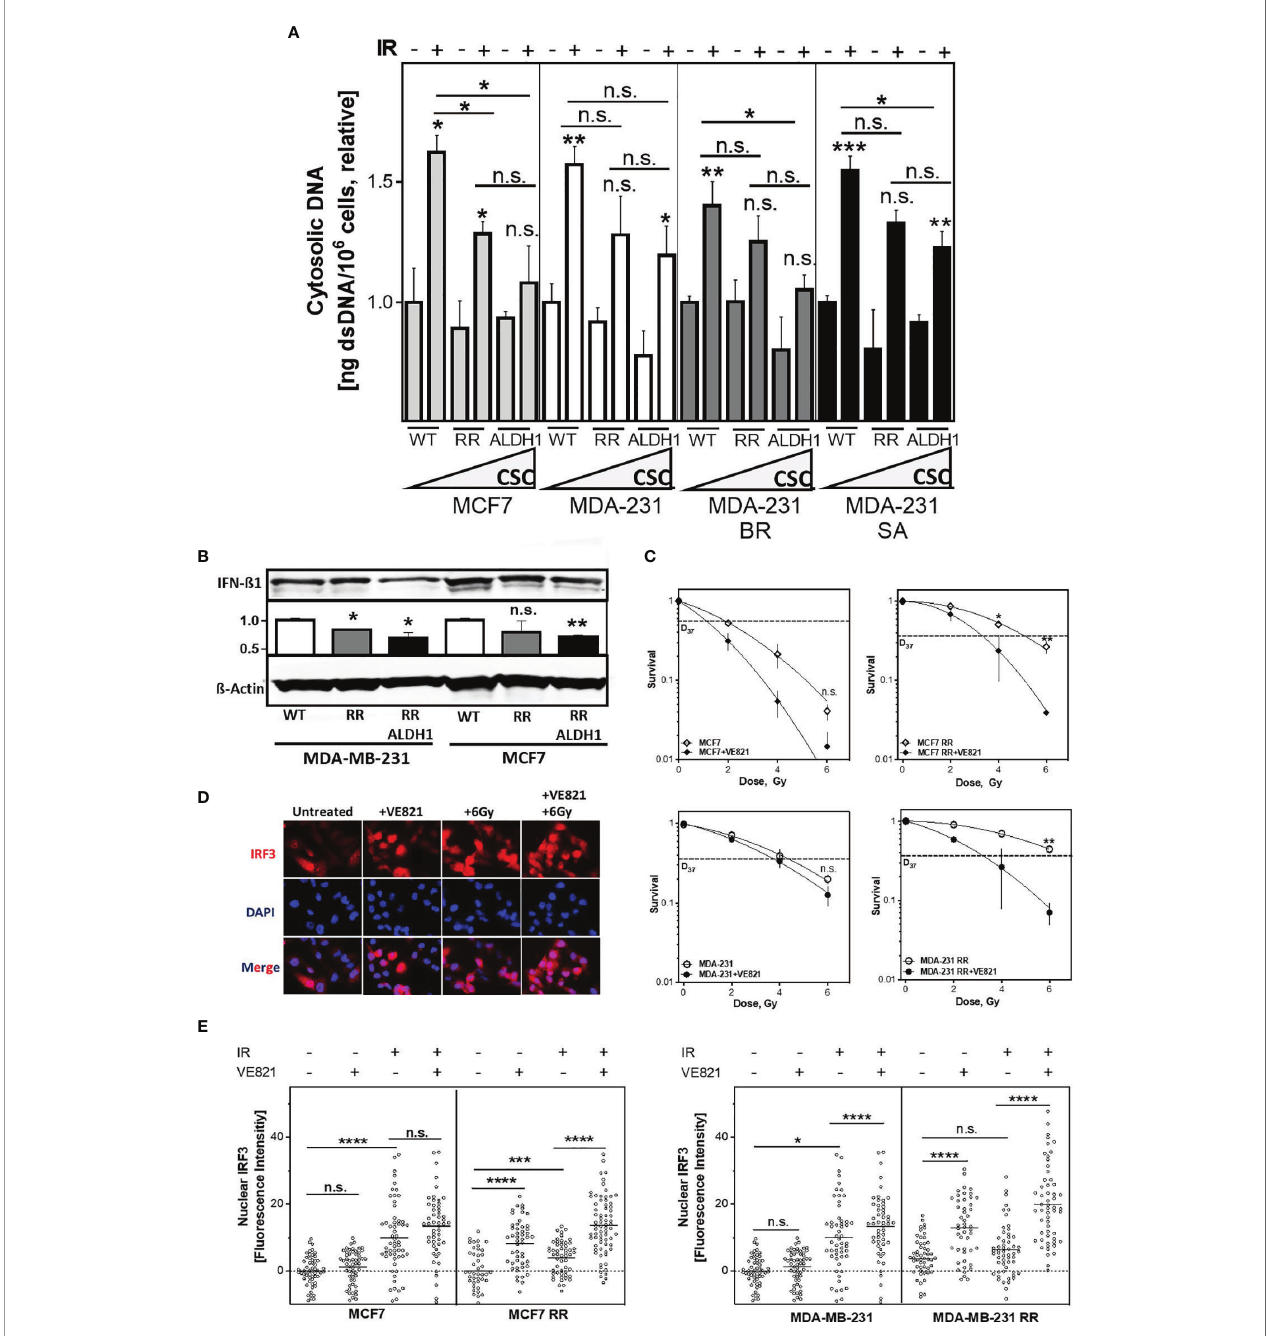
FIGURE 5 | The amount of cytosolic DNA and intracellular immune response depends on the ALDH1-positive BCSC proportion. (A) Relative increase of cytosolic dsDNA after irradiation. Cells were irradiated with 8 Gy, cytoplasmatic fraction isolated and dsDNA stained with PicoGreen ® reagent, quanti fi ed in a Spark ® reader and normalized to the untreated control or (B) Expression of IFN-ß1 after irradiation. Cells were irradiated with 8 Gy and proteins were extracted 24h later. Proteins were separated and transferred by Western blotting. IFN-ß was detected speci fi c primary antibodies, followed by fl uorescence-coupled secondary antibodies. ß- Actin served as a loading control. The Expression of IFN-ß was normalized to the wild type cell lines. (C) Cellular survival after irradiation. Cells were seeded 6 hours prior to treatment, treated with +/- VE821 2h prior to irradiation, irradiated with the indicated doses, fi xed after 14 days and the number of colonies was counted. (D, E) Nuclear IRF3 accumulation. Cells were incubated with 1µM VE821 for 2h, irradiated with 6Gy and fi xed 16h later. IRF3 was stained with a speci fi c primary antibody, followed by a fl uorescent secondary antibody. Nuclei were stained with DAPI. Fluorescence intensity (FI) of IRF3 was quanti fi ed with Image J Nuclear IRF3 was calculated by subtraction of the cytoplasmatic FI from the nuclear FI. Shown are means of three independent experiments ± SEM. Asterisks (*) represent signi fi cant differences (n.s., not signi fi cant; *p < 0.05; **p < 0.01; ***p < 0.001, ****p < 0.0001, Student ’ s